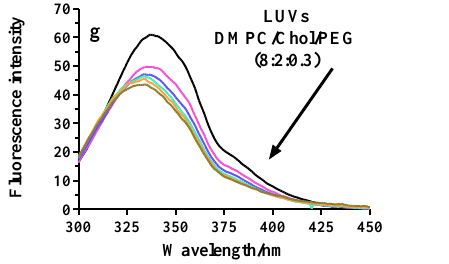
Figure 3. Fluorescence spectra obtained after the incubation of BSA with PC or DMPC LUVs or MLs. ( a ) LUVs PC/Chol (8:2); ( b ) MLs PC/Chol (8:2); ( c ) LUVs DMPC/Chol (8:2); ( d ) MLs DMPC/Chol (8:2); ( e ) LUVs PC/Chol/PEG (8:2:0.3); ( f ) MLVs PC/Chol/PEG (8:2:0.3); ( g ) LUVs DMPC/Chol/PEG (8:2:0.3); ( h ) MLVs DMPC/Chol/PEG (8:2:0.3). The black line corresponds to the spectrum of 5 µM free BSA while the rest refer to the recordings after consecutive additions of 5 µL of 20 mM LUVs or MLs. The arrow indicates the direction of increase in LUVs or MLs concentration ranging from 62 to 370 µM into the reaction cuvette. λ exc : 280 nm. The intensity of the emission band at 338 nm corresponding to the tryptophan was used for the calculation of the Stern-Volmer constant ( K SV ) [51].